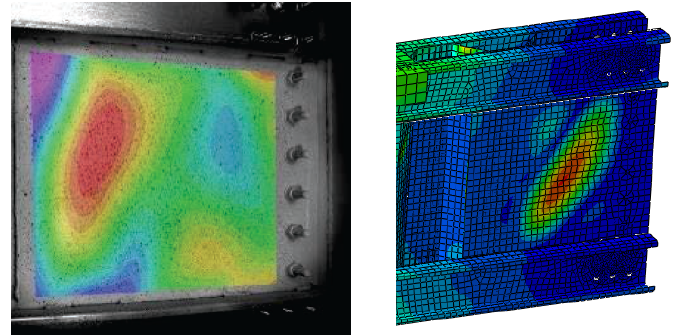
Figure 10. Geometrical imperfections observed in the experiment vs. FEM.